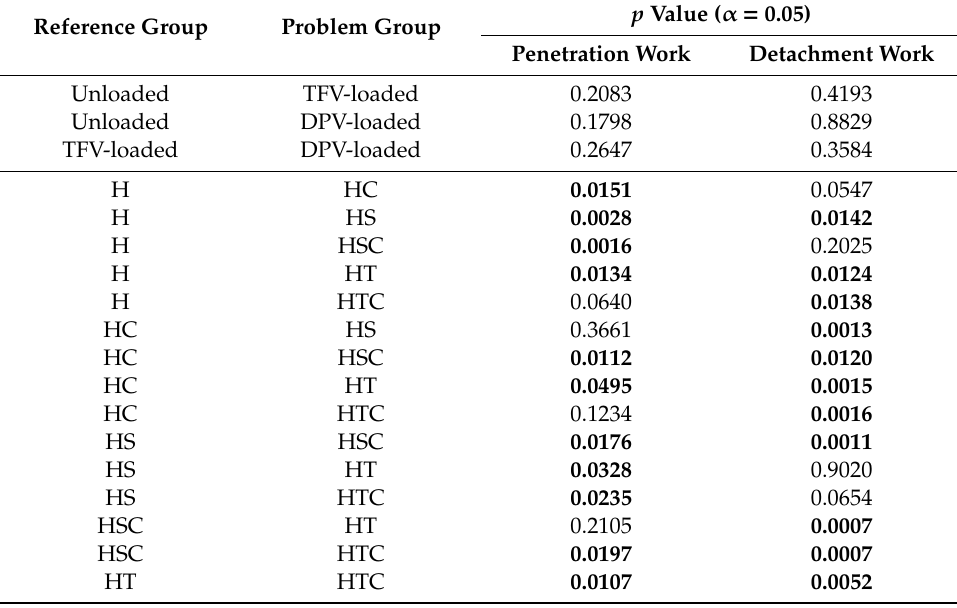
Table 2. p -Values obtained in the comparison of the group of batches by a paired t -test. Significant differences are in bold.